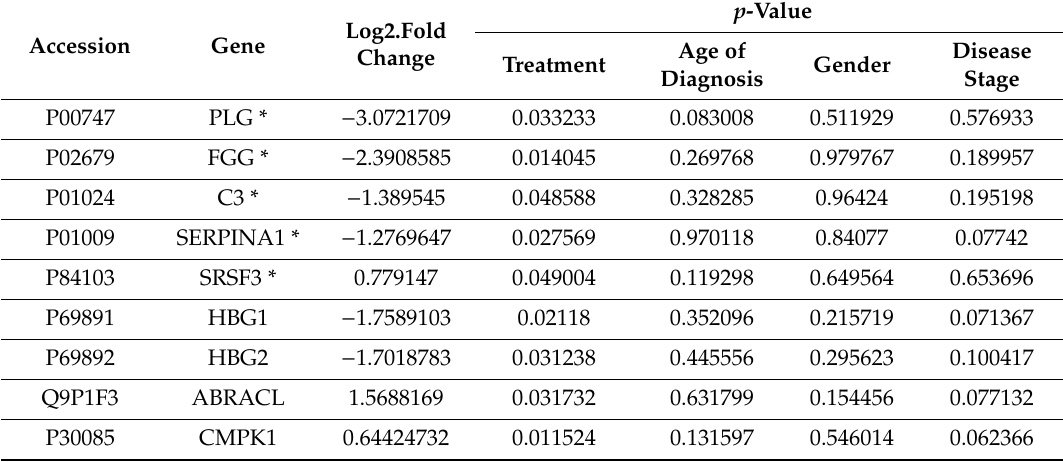
Table 2. Di ff erentially expressed proteins between patients with neoadjuvant therapy and no preoperative